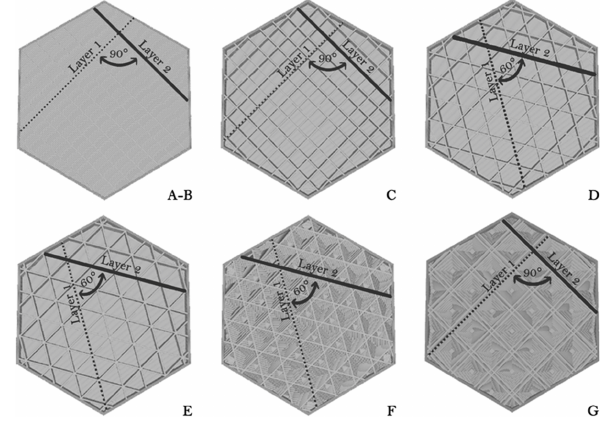
Table 1: Specimens characteristics relative ASTM-D638